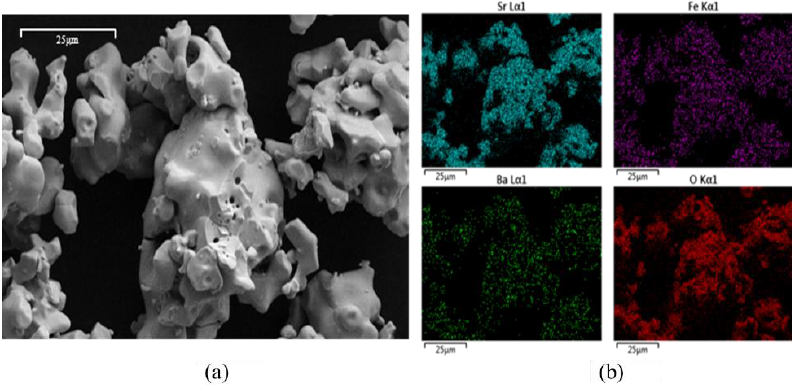
Figure 6. Images of Ba 0.1 Sr 0.9 FeO 3−δ from ( a ) scanning electron microscopy and ( b ) atomic distribution of Sr (blue), Fe (purple), and Ba (green) cations and O (red) anions from energy dispersive X-ray spectroscopy.